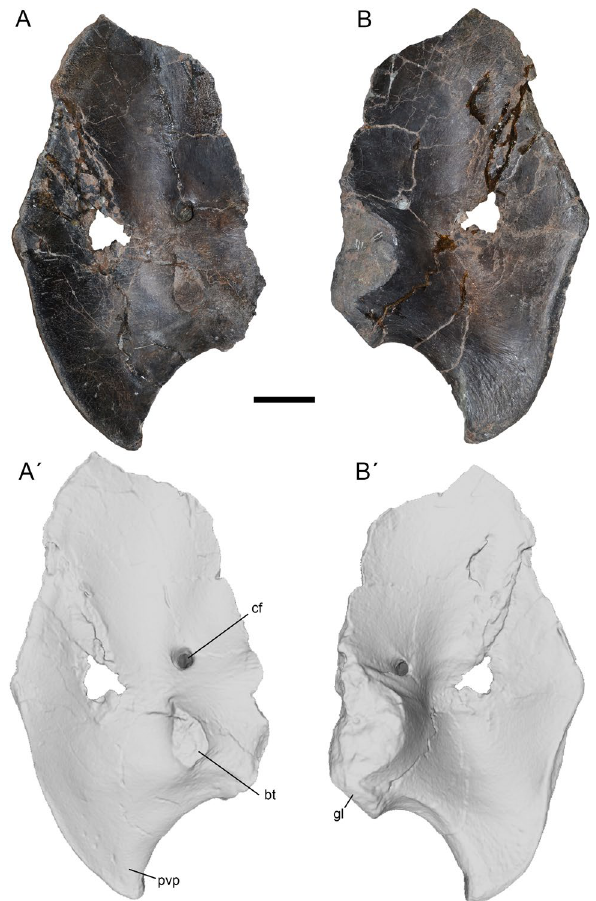
Figure 13. Coracoid of Maip in lateral ( A, A´ ) and medial ( B, B´ ) views. Scale bar: 5 cm. Abbreviations: bt, biceps tubercle; cf, coracoid foramen; gl, glenoid cavity; pvp, posteroventral